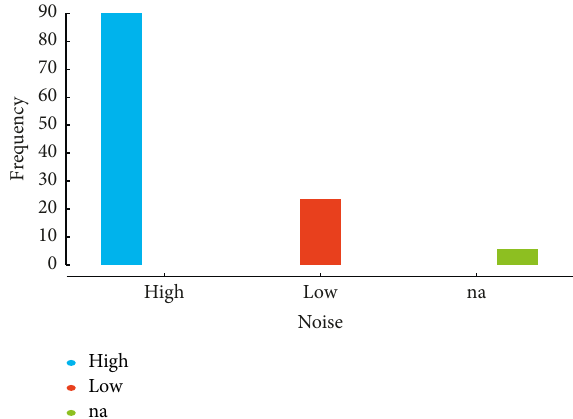
Figure 7: Leq feature distribution in dataset generated by Orange tool with respect to noise feature. Table 3: The performance parameters generated using the Orange tool for evaluation.